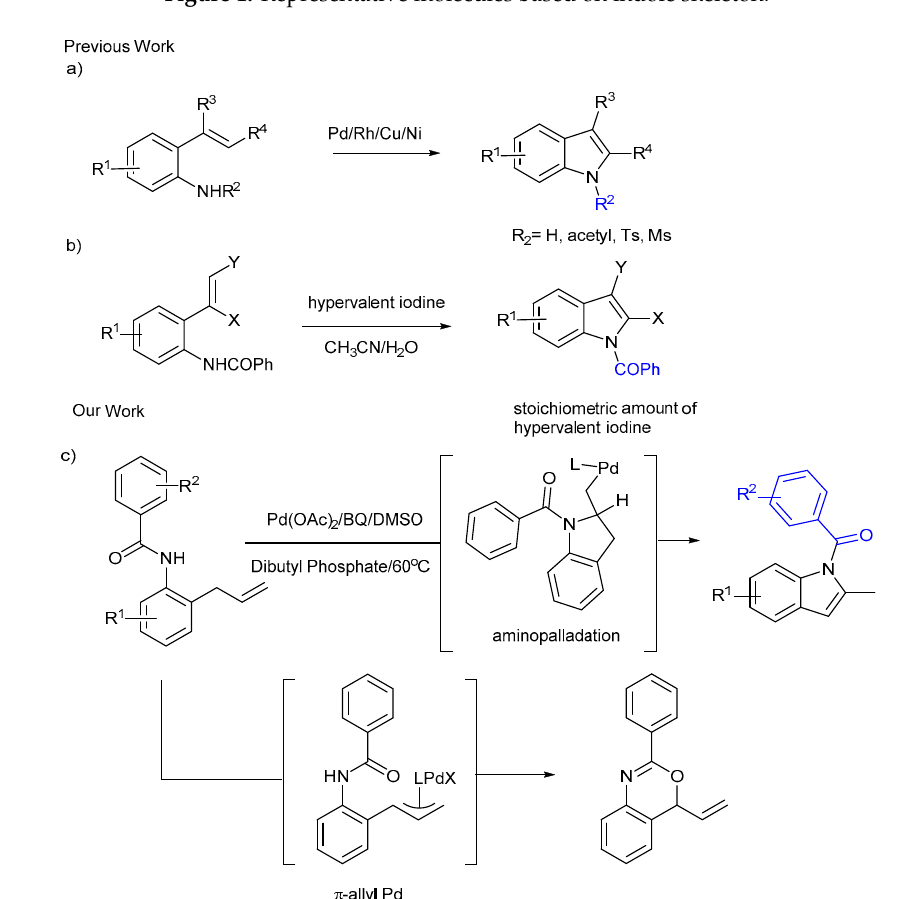
Figure 2. Methods for synthesis of substituted N -benzoylindole. ( a ) The synthesis of indoles by employing transition-metal-catalyzed. ( b ) The synthesis of N -benzoylindole by hypervalent iodine as the oxidant. ( c ) This work.